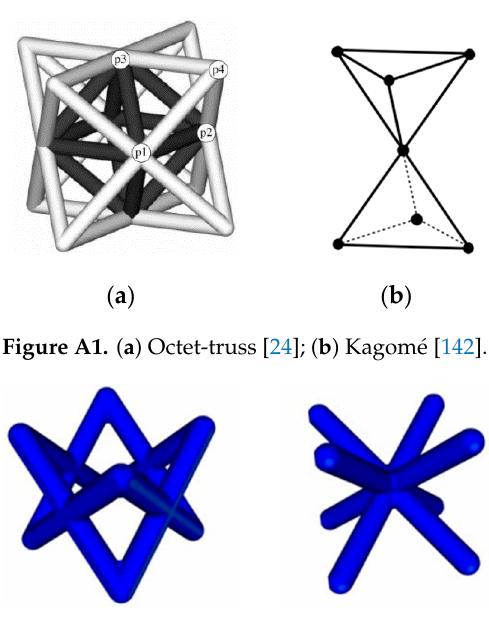
Figure A2. ( a ) Diagonal; ( b ) Octahedral [143].